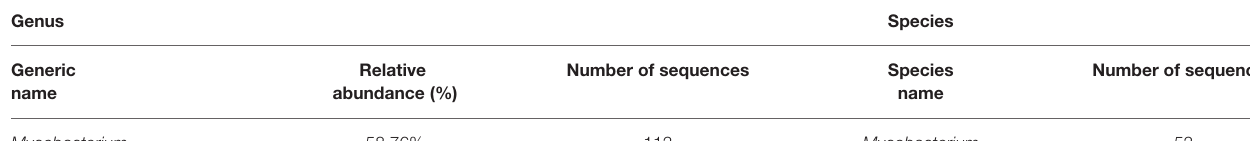
TABLE 1 | mNGS results of the tissue and exudate from the punctures in this case.